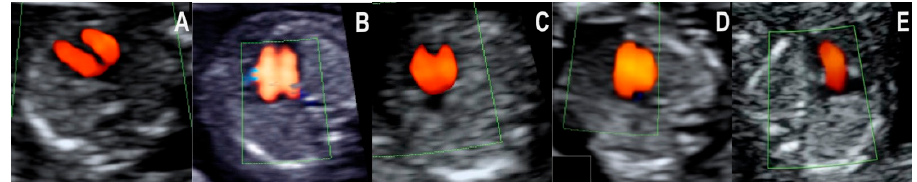
Figure 1. Color doppler flow patterns encountered in the four-chamber view. ( A ): Normal filling of both ventricles. ( B ): Filling of both ventricles, but the cardiac axis is abnormally shifted to the left. ( C ): Common inflow into the ventricles. ( D ): Filling of both ventricles, but the left ventricle appears smaller. ( E ): Filling of only one ventricle.